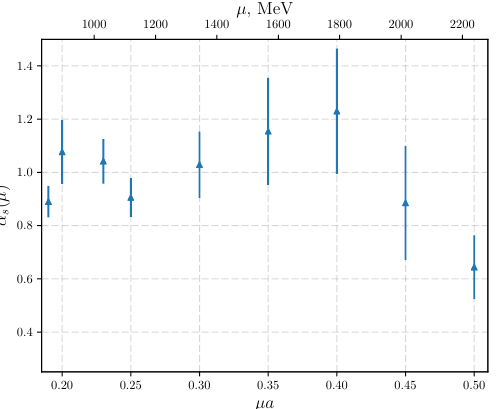
Figure 13 . The strong coupling constant (cid:11) s as a function of the chemical potential calculated from the (cid:12)t of lattice data by formula